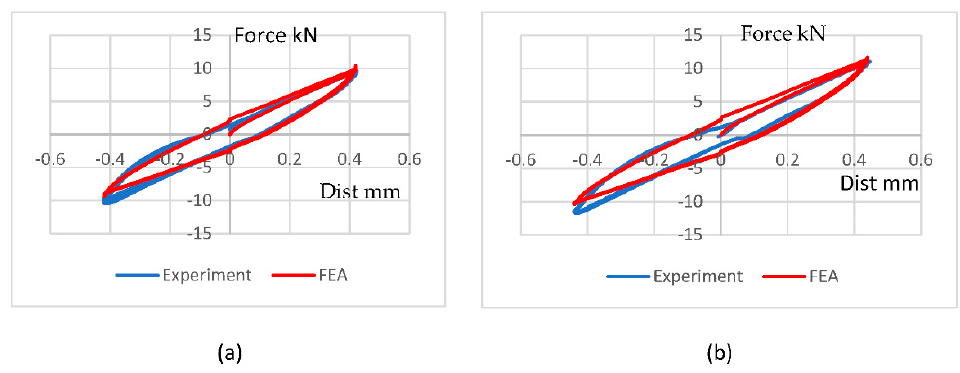
Figure 14. Comparison of load–displacement curves under ( a ) 0.01 Hz and ( b ) 0.5 Hz.